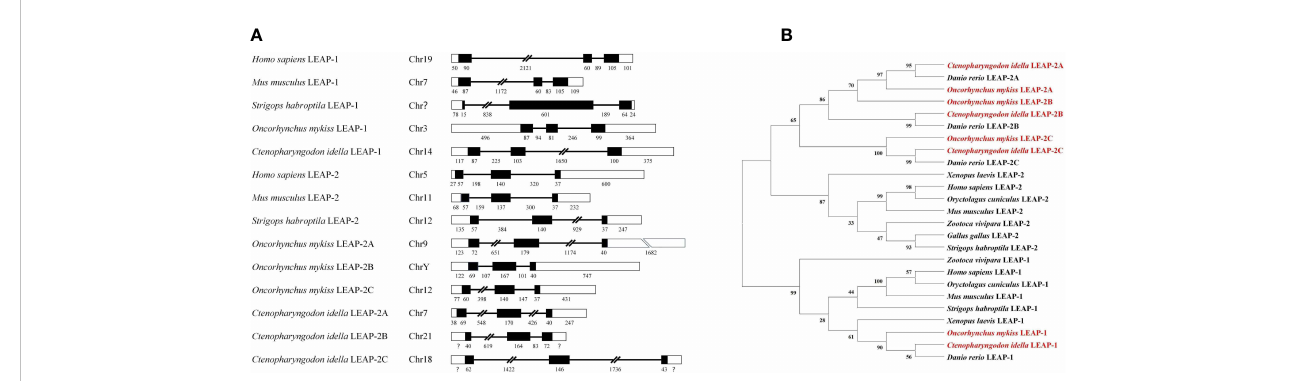
FIGURE 2 Gene structure and phylogenetic relationship of vertebrate LEAPs. (A) Gene structure of LEAPs from Homo sapiens , Mus musculus , Strigops habroptila , Oncorhynchus mykiss , and Ctenopharyngodon idella . The rectangles represent the exons, and the lines between them indicate the introns. Black and white areas indicate the coding regions and untranslated regions, respectively. The sizes of the exons and introns are shown by the numbers below. GenBank accession numbers of the selected sequences are listed in Table 1. The question mark means the length is unknown. (B) Phylogenetic relationship of LEAPs. A neighbour-joining phylogenetic tree was generated using the MEGA program with 1000 bootstrap replications. Rainbow trout and grass carp LEAPs are in red. GenBank accession numbers of the selected sequences are listed in Table